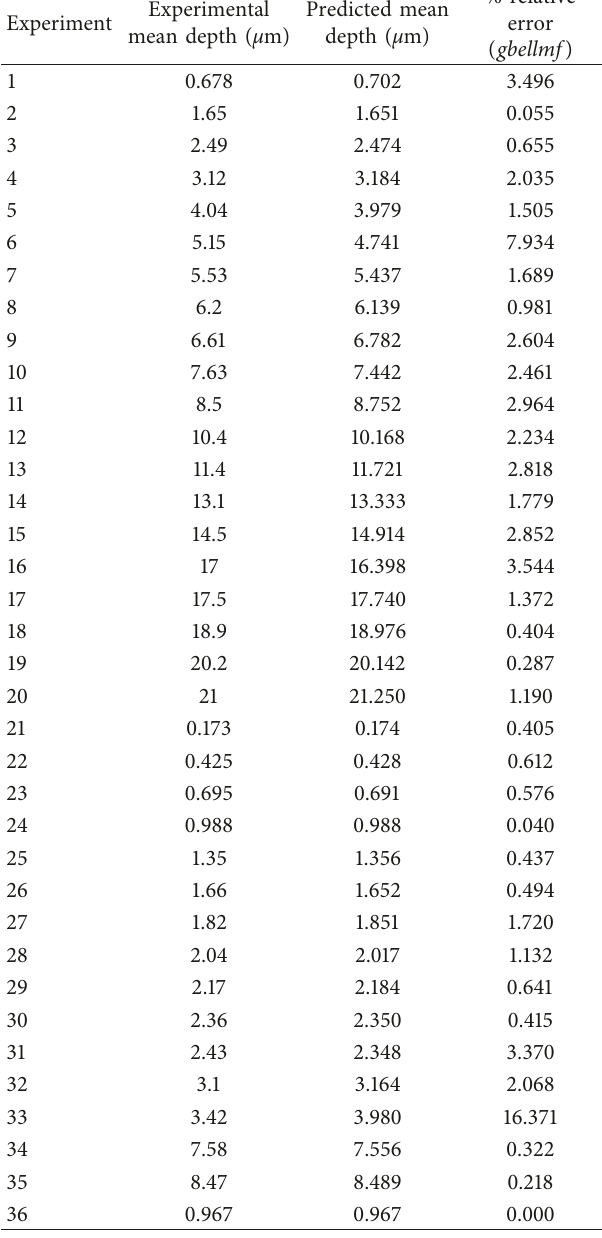
Table 3: Comparison of experimental and predicted mean depths and their relative errors.